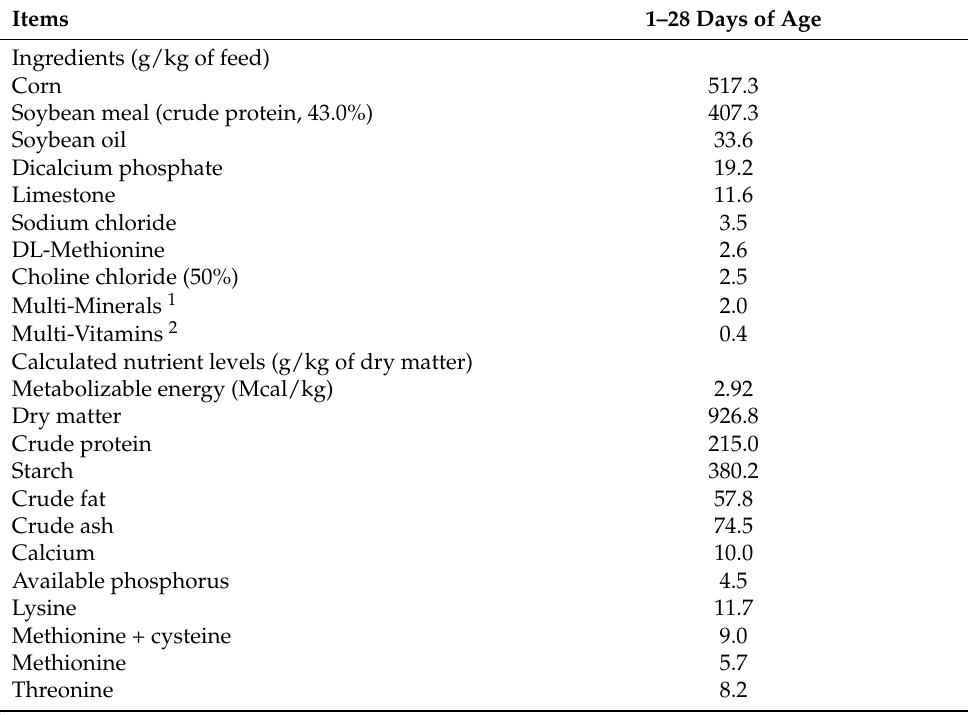
Table 1. Ingredients and nutrient composition of basal